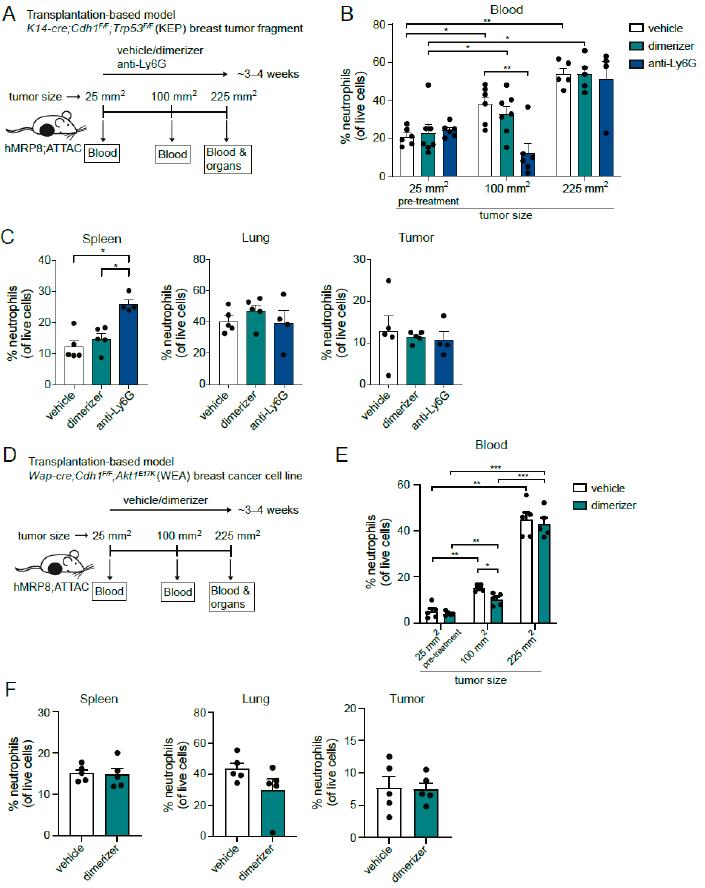
Figure 4. Dimerizer treatment is ineffective in depleting neutrophils on the long-term in mammary tumor-bearing hMRP8-ATTAC mice. ( A ) Illustration of the experimental design. Female homozy- gous hMRP8-ATTAC mice were orthotopically transplanted in the mammary fat pad with K14- cre;Cdh1 F/F ;Trp53 F/F tumor fragments. Mice were treated with either vehicle, dimerizer or anti-Ly6G until sacrifice at a tumor size of 225 mm 2 . Blood was collected before the start of the treatment (25 mm 2 ) and at a tumor size of 100 mm 2 . At a tumor size of 225 mm 2 , mice were sacrificed, and blood and organs were collected for flow cytometry analysis. ( B ) Frequency of neutrophils in the blood of hMRP8-ATTAC mice treated as indicated ( n = 6–7/treatment group) at a tumor size of 25 mm 2 , 100 mm 2 , and 225 mm 2 , as determined by flow cytometry. ( C ) Frequency of neutrophils in spleen, lung, and tumor of endpoint hMRP8-ATTAC mice ( n = 4–5), as determined by flow cytometry. ( D ) Sche- matic of the experimental set-up. Orthotopic intramammary injection of Wap-cre;Cdh1 F/F ;Akt1 E17K (WEA) breast cancer cells was performed in female homozygous hMRP8-